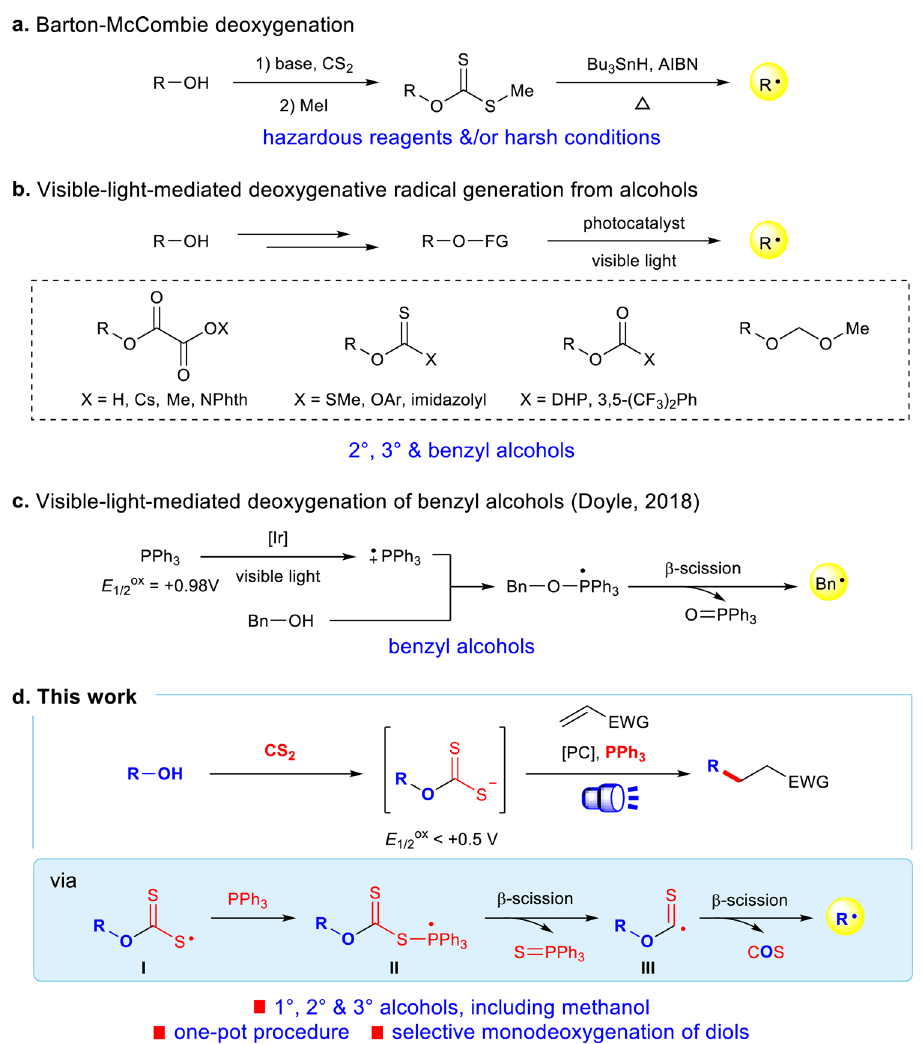
Fig. 1 Deoxygenative alkyl radical generation from alcohols under visible-light photoredox conditions. a Barton – McCombie deoxygenation; b visible- light-mediated deoxygenative radical generation from alcohols; c visible-light-mediated deoxygenation of benzyl alcohols. d Our work. FG functional group, [Ir] [Ir(dFMeppy) 2 dtbbpy]PF 6 , PC photocatalyst, EWG electron-withdrawing